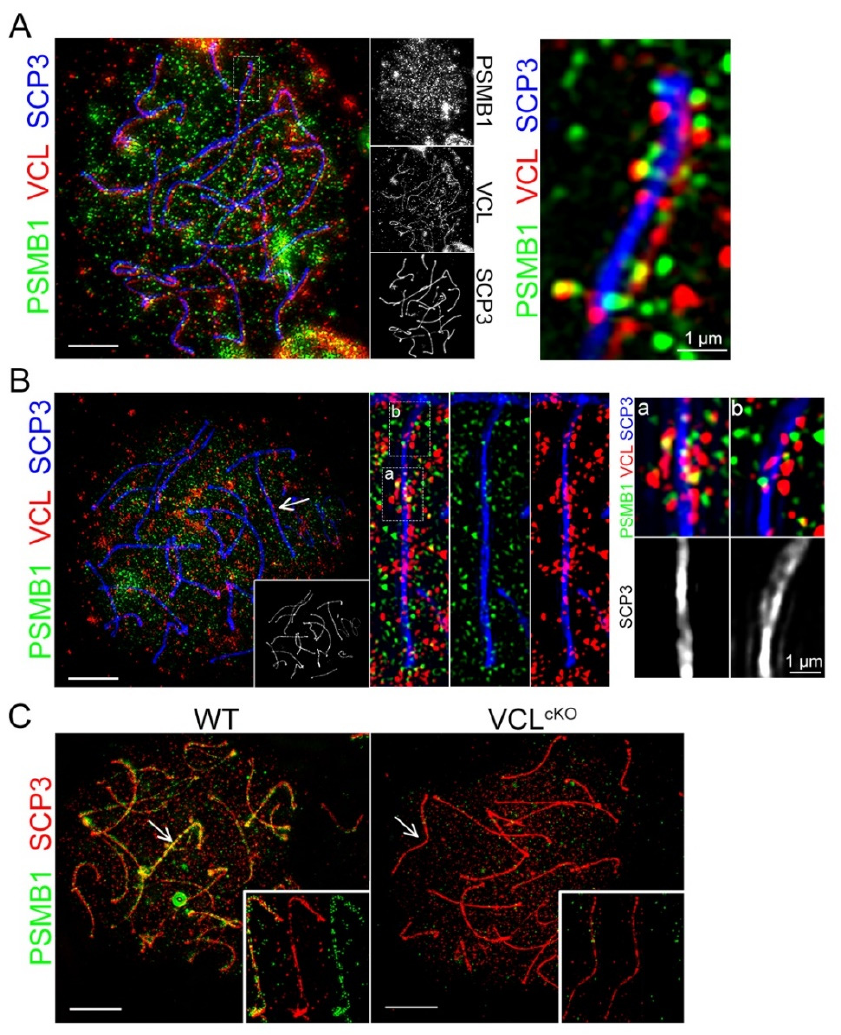
Figure 9. VCL associated with proteasome complexes in the area of the full synapse, and its depletion detached the proteasome from the chromosome axes; ( A ) co-localization of VCL and PSMB in the pachytene spermatocytes was not strong. However, from detailed observation, these two proteins might appear to associate at chromosomal axes; ( B ) VCL/PSMB aggregates appeared more frequently together at the SCP3 full synapsis (a) but not when the SCP3 axes were separate (b); ( C ) the best localization pattern of PSMB in the pachytene spermatocyte visualized by STED. The decorating pattern on the axes was not observed in VCL cKO spermatocytes.